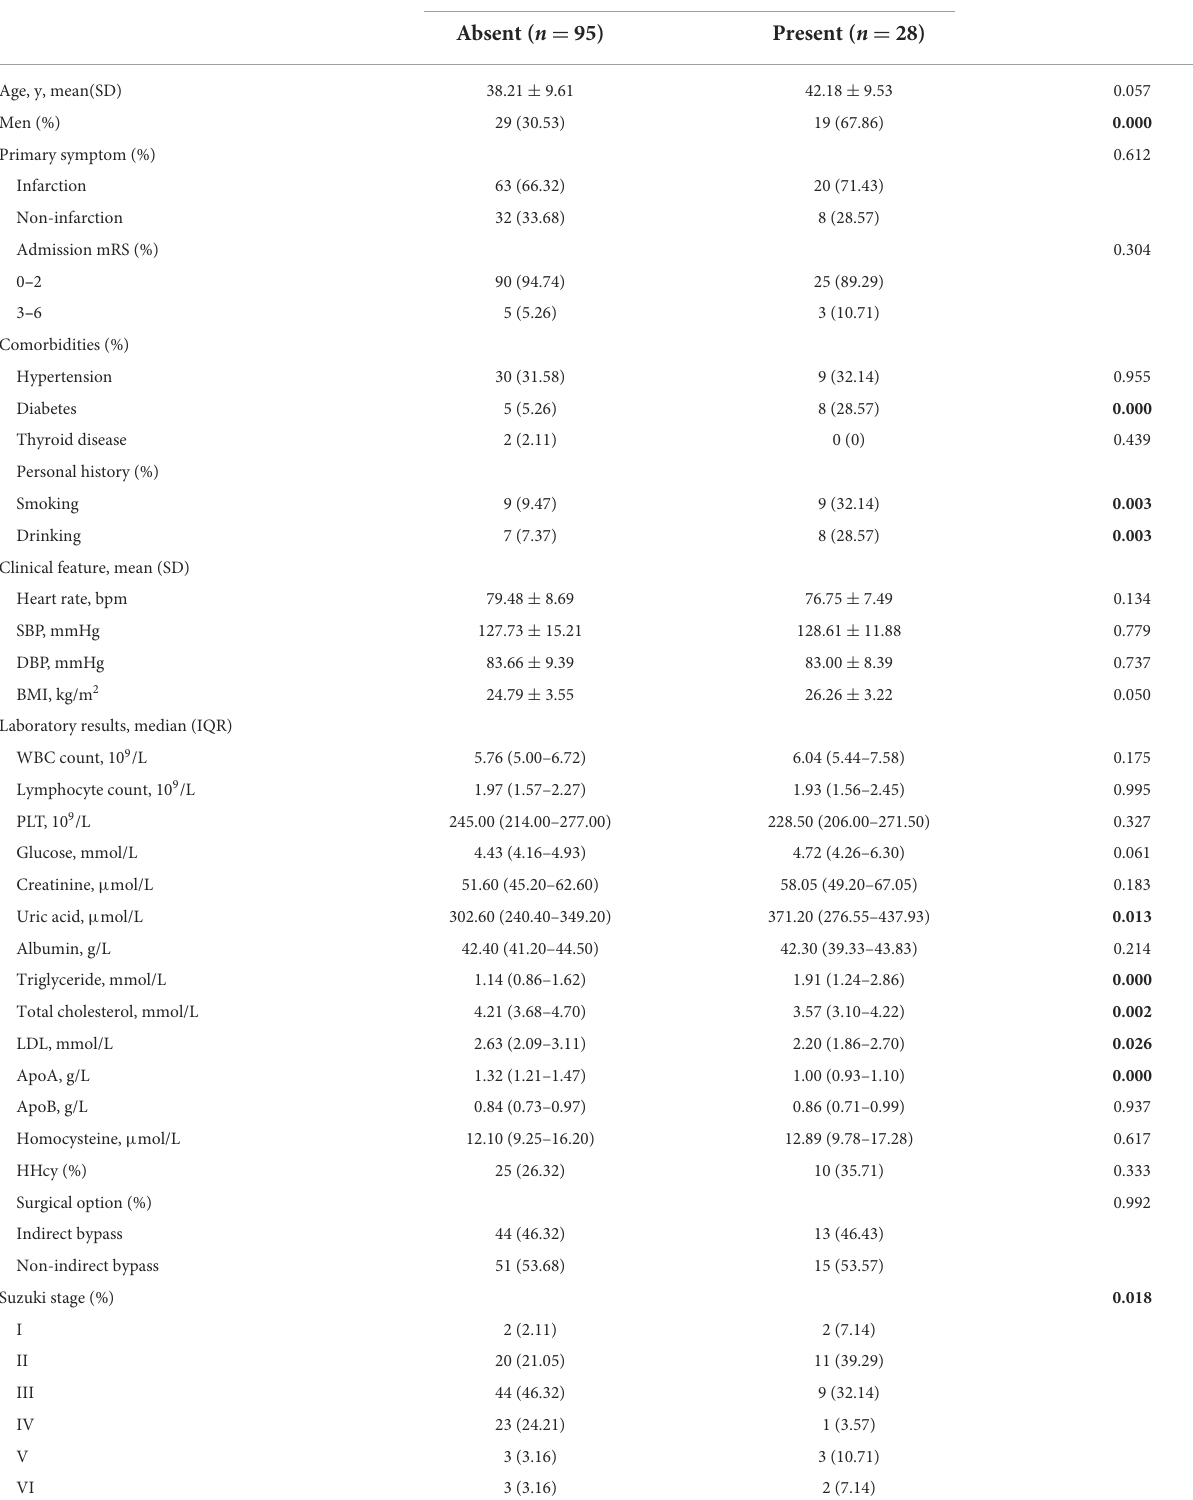
TABLE 2 Clinical characteristics of the participants with and without